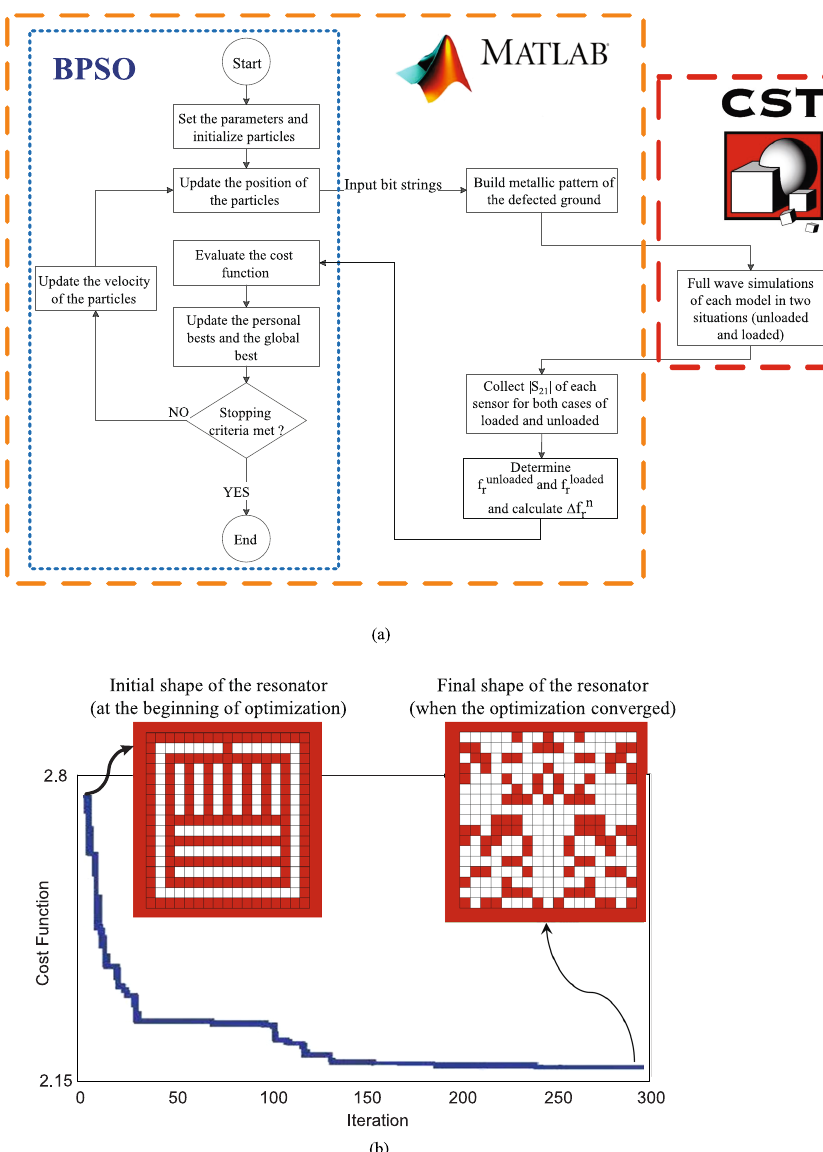
Figure 19. Sensor shape optimization in Matlab coupled with CST: ( a ) flowchart of the design procedure; ( b ) the value of the cost function during the iterations of the optimization algorithm; the left and right insets show the initial and final shapes of the resonator at the beginning and end of the optimization procedure, respectively. Reprinted with permission from Ref.